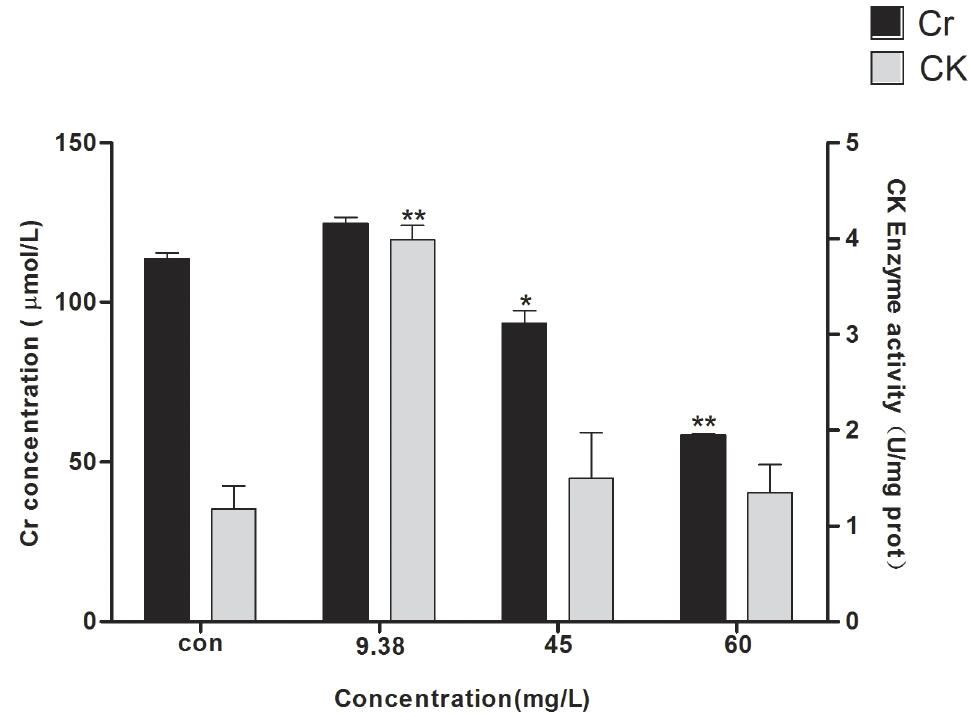
Figure 5. The effects of DKA concentrations on CK activities and Cr concentrations.